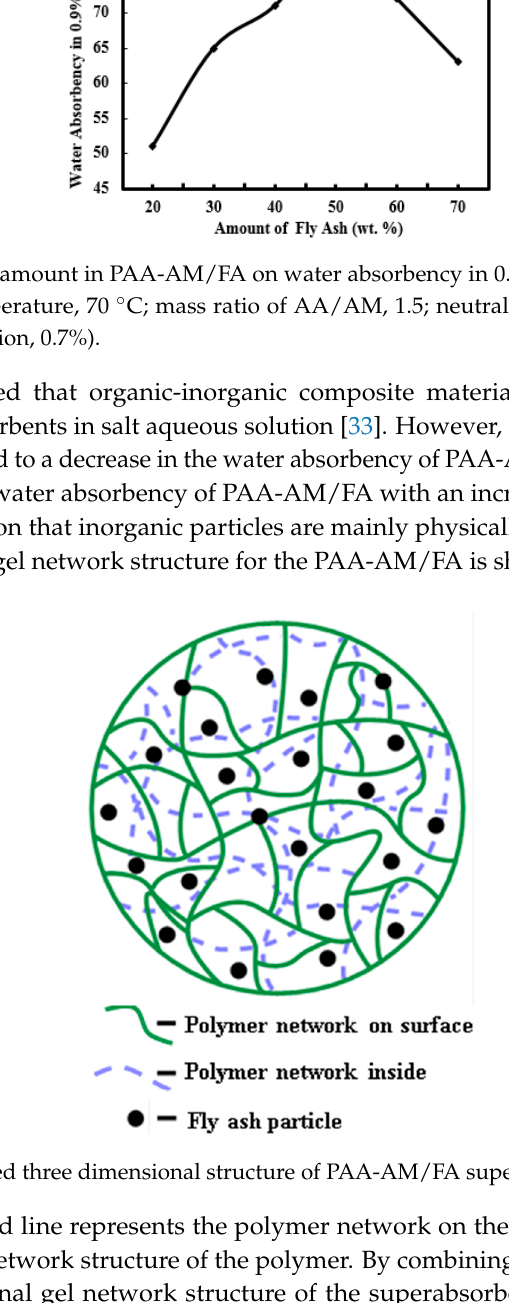
Figure 6. Proposed three dimensional structure of PAA-AM/FA superabsorbent composite.